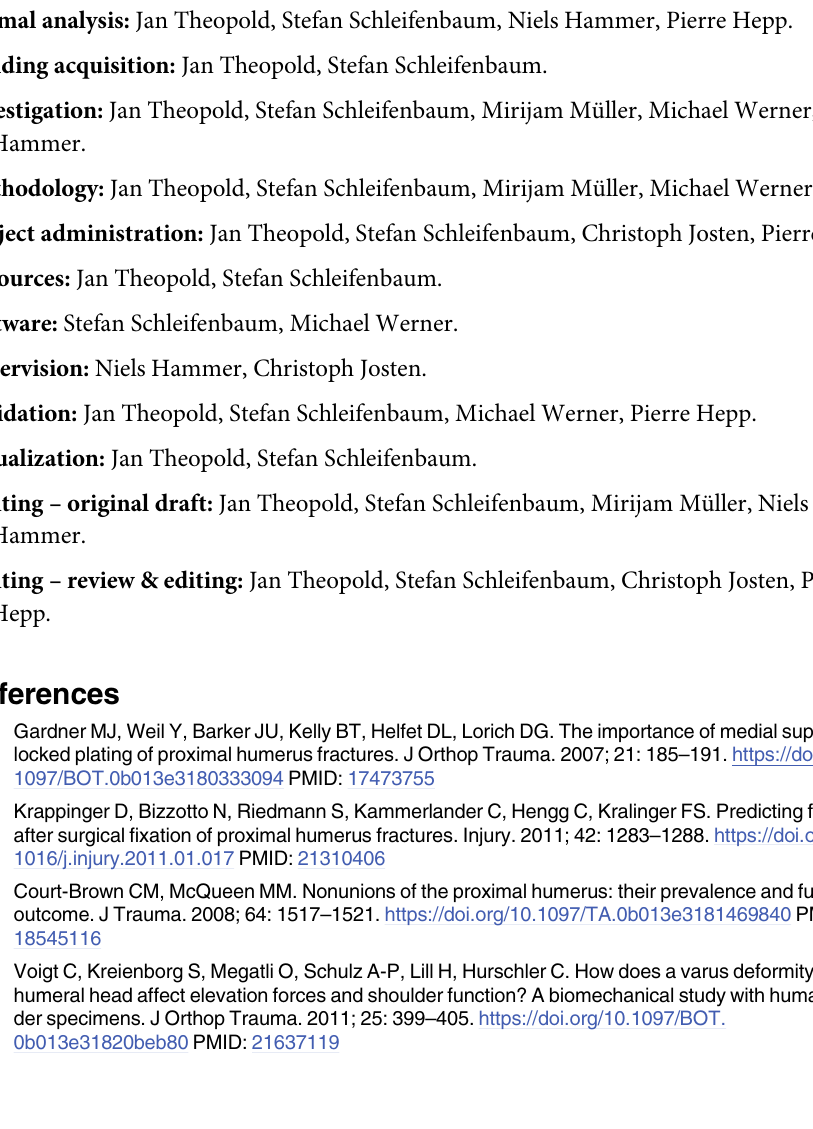
S1 Table. Table with the raw